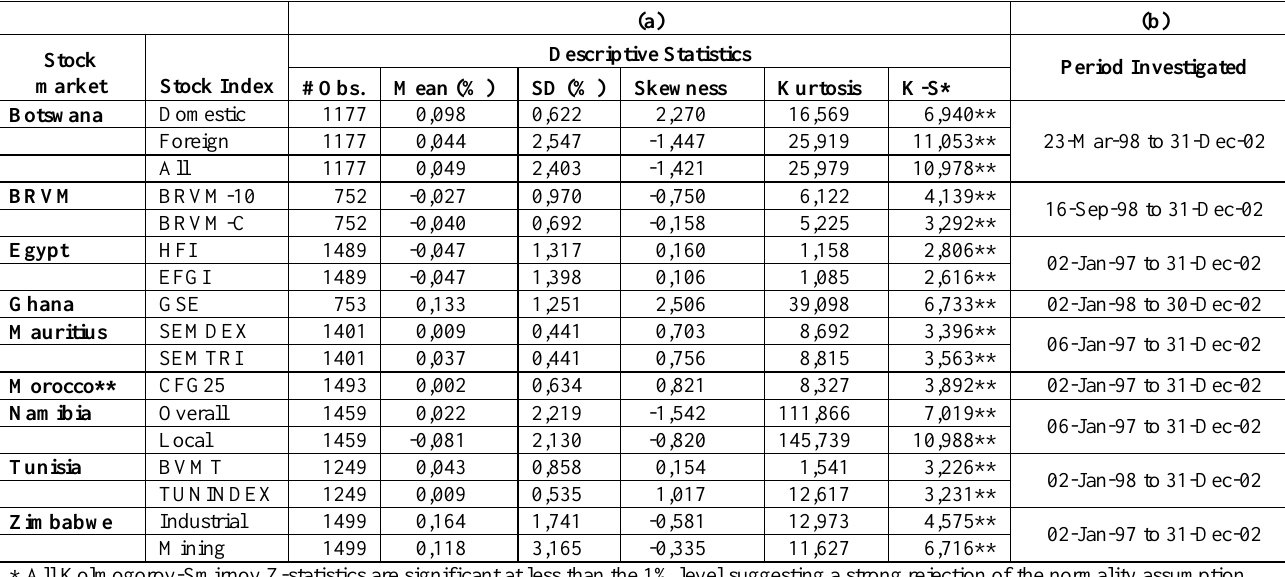
Table 1: General and Descriptive Statistics for the Index